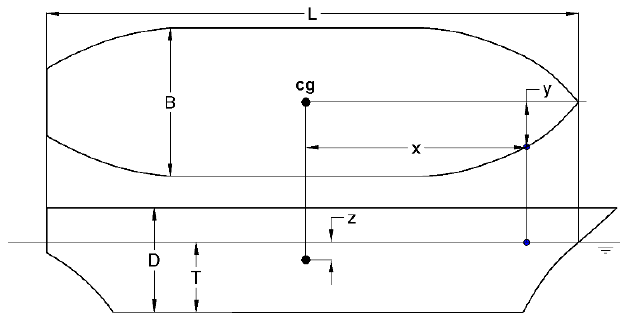
Figure 5. Definitions of geometric parameters at a ship-ice collision point.